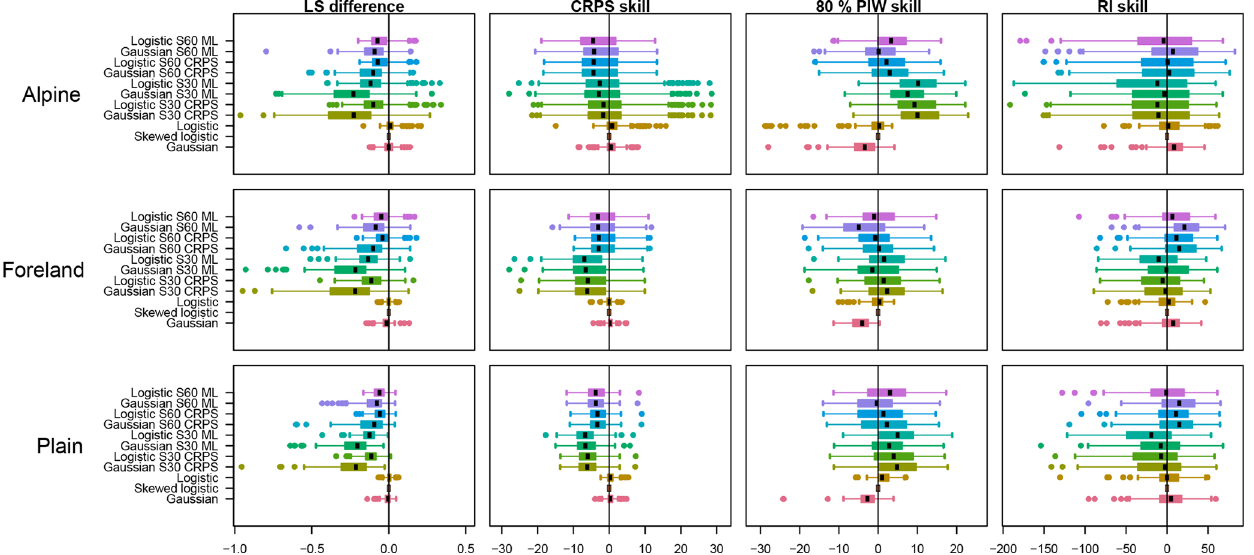
Figure 9. As in Fig. 8, but showing the improvements against the skewed logistic model. Note that improvements are reported by positive values. Differences are shown for LS, whereas skill scores (in %) are shown for CRPS, the 80% PIW, and the